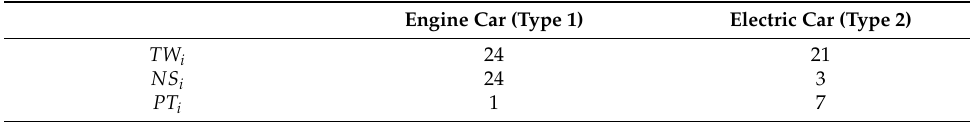
Table 2. Basic data of two underbody lines.